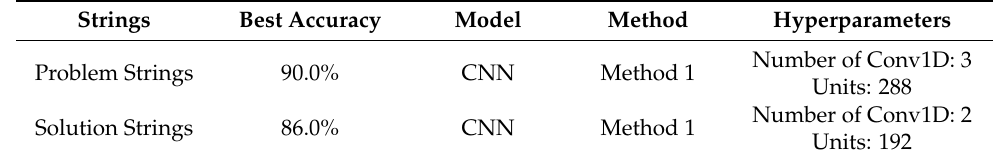
Table 12. Best performing CNN